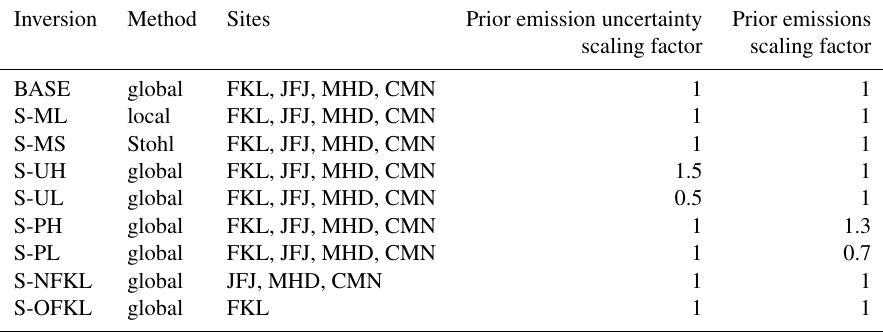
Table 1. Setup for the base inversion (BASE) and the sensitivity inversions (S-XX). Method refers to the uncertainty treatment explained in section 2.7. The sites are abbreviated as follows: Finokalia (FKL), Jungfraujoch (JFJ), Mace Head (MHD) and Monte Cimone